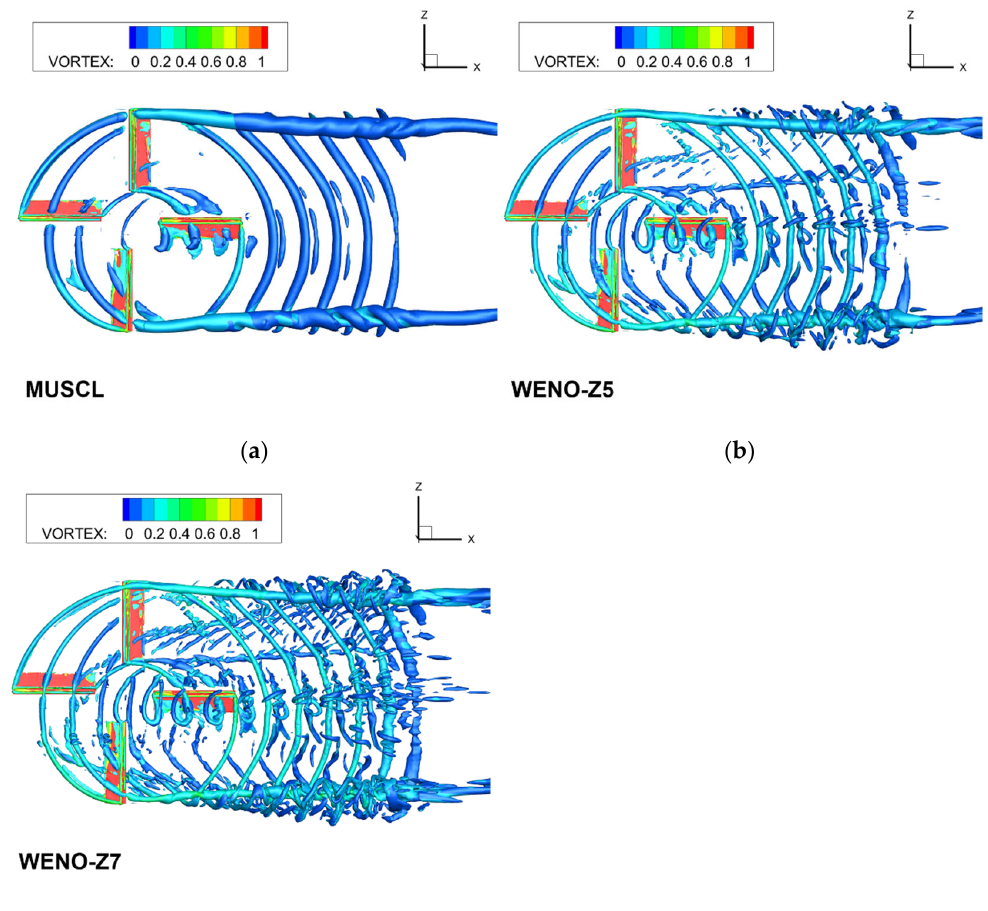
Figure 6. The iso ‐ surfaces of the Q criterion at Q = 0.001 (colored by the vorticity magnitude) of the Helishape ‐ 7A rotor for the WENO ‐ Z and the MUSCL schemes: ( a ) MUSCL; ( b ) WENO ‐ Z5; ( c ) WENO ‐ Z7.